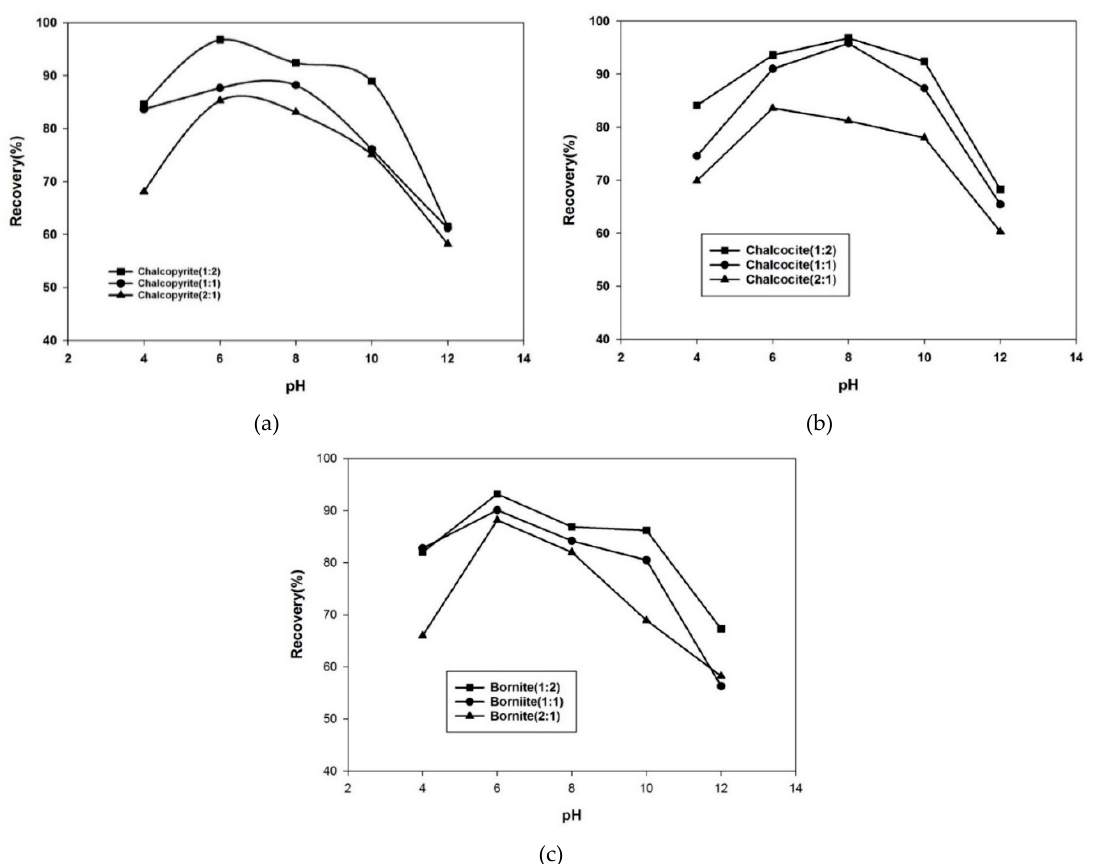
Figure 9. The Hallimond flotation recovery of ( a ) chalcopyrite, ( b ) chalcocite, and ( c ) bornite in the presence of a collector blend as a function of pH at collector concentration 3 × 10 − 5 M.